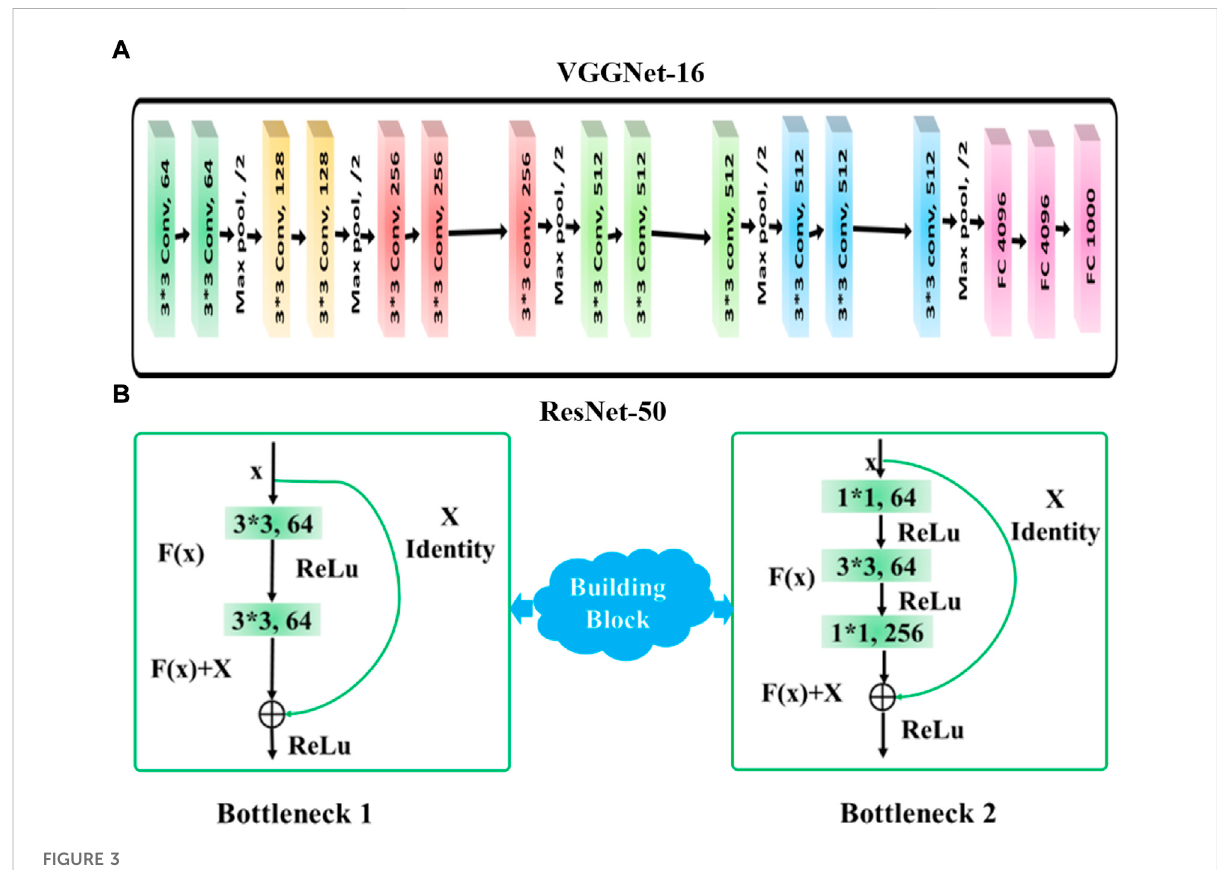
FIGURE 3 (A) VGGNet-16 structure; (B) ResNet-50